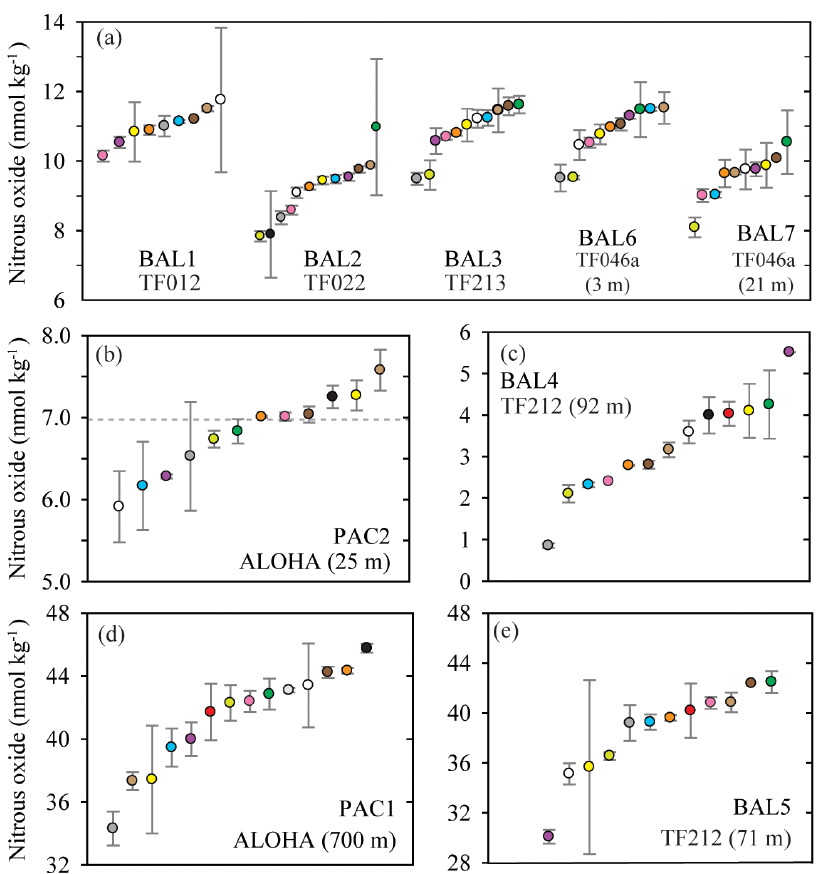
Figure 4. Concentrations of nitrous oxide measured in nine separate samples from the Baltic Sea and the Pacific Ocean. The dashed grey line represents the value of nitrous oxide at atmospheric equilibrium (b) . Individual data points are plotted sequentially by increasing value. The same color symbol is used for each laboratory in all